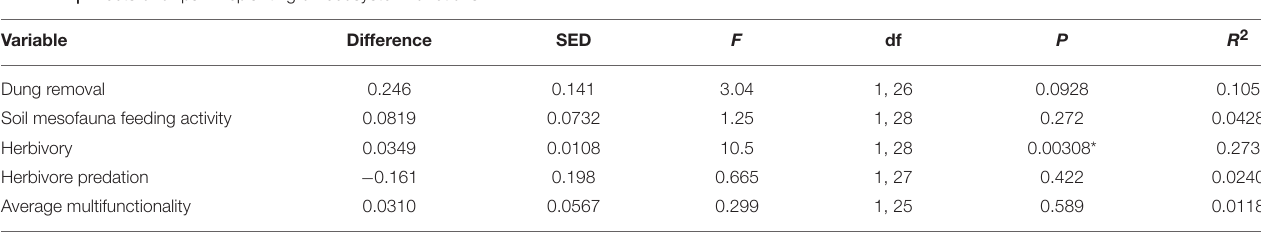
TABLE 2 | Effects of oil palm replanting on ecosystem functions. Variable Difference